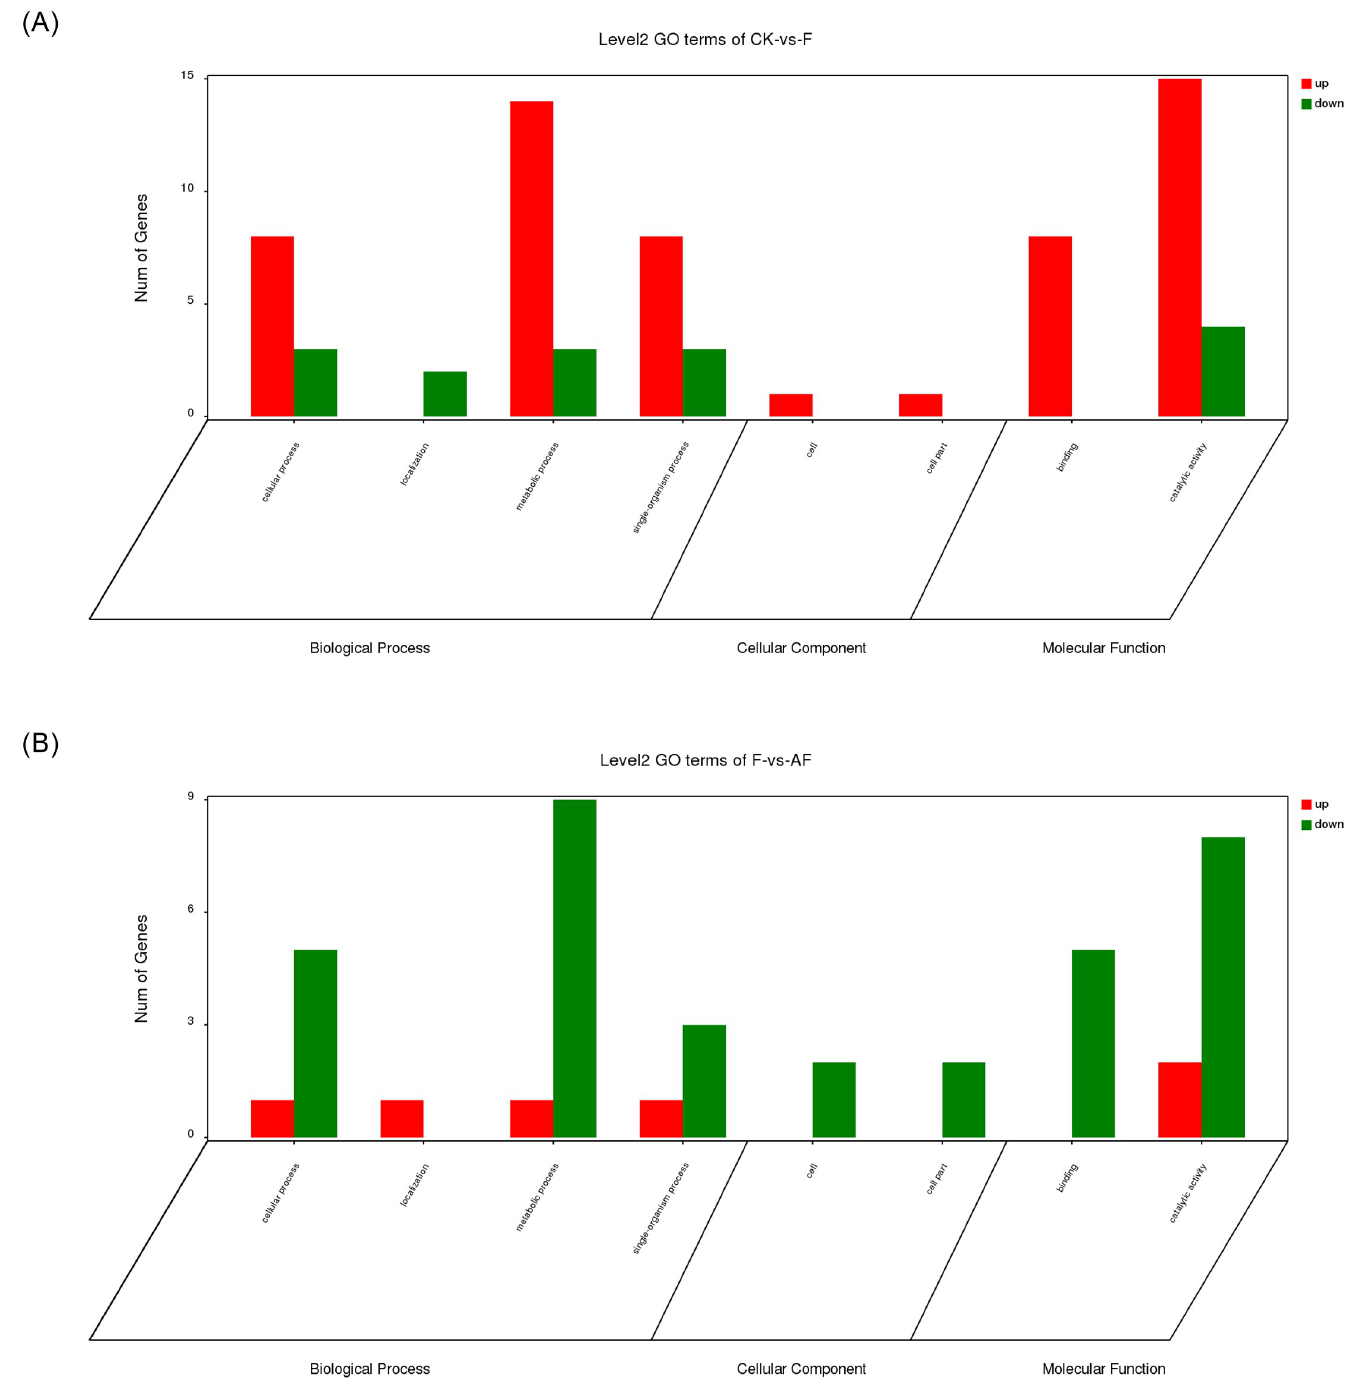
Fig 7. GO enrichment analysis of DEGs. DEGs in each group were sorted into three categories. Green bars indicate downregulated genes, and red bars indicate upregulated genes. The x-axis indicates different GO terms. The y-axis represents the number of genes in the indicated categories. (A) CK-vs.-F comparison; (B) F-vs.- AF